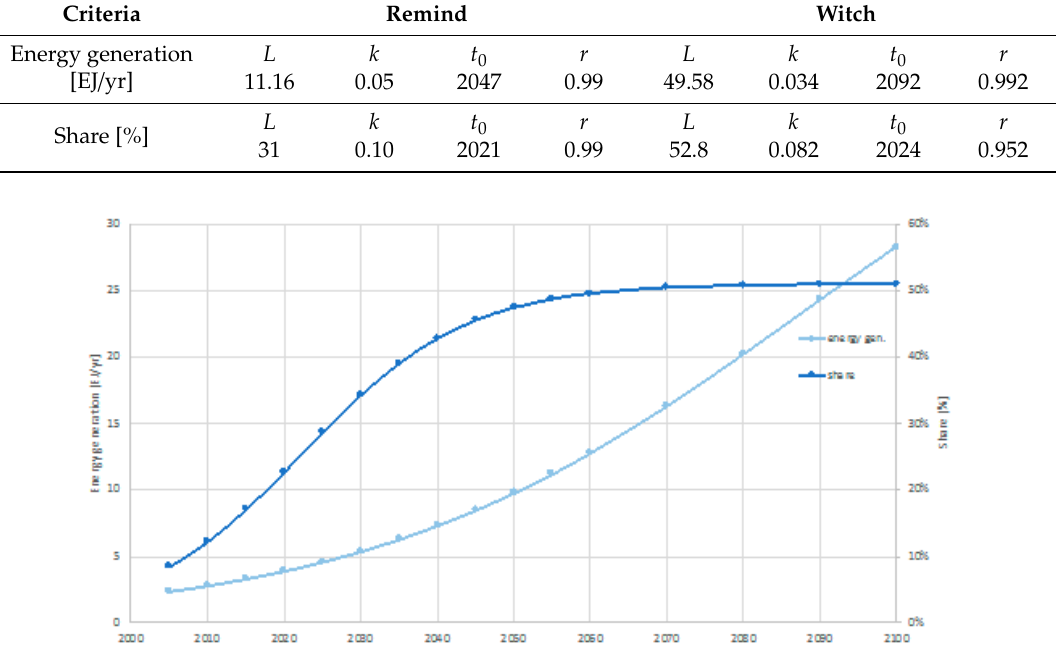
Figure 10. Europe Wind technology energy generation development based on Reference Scenario of WITCH until year 2100 (own work).